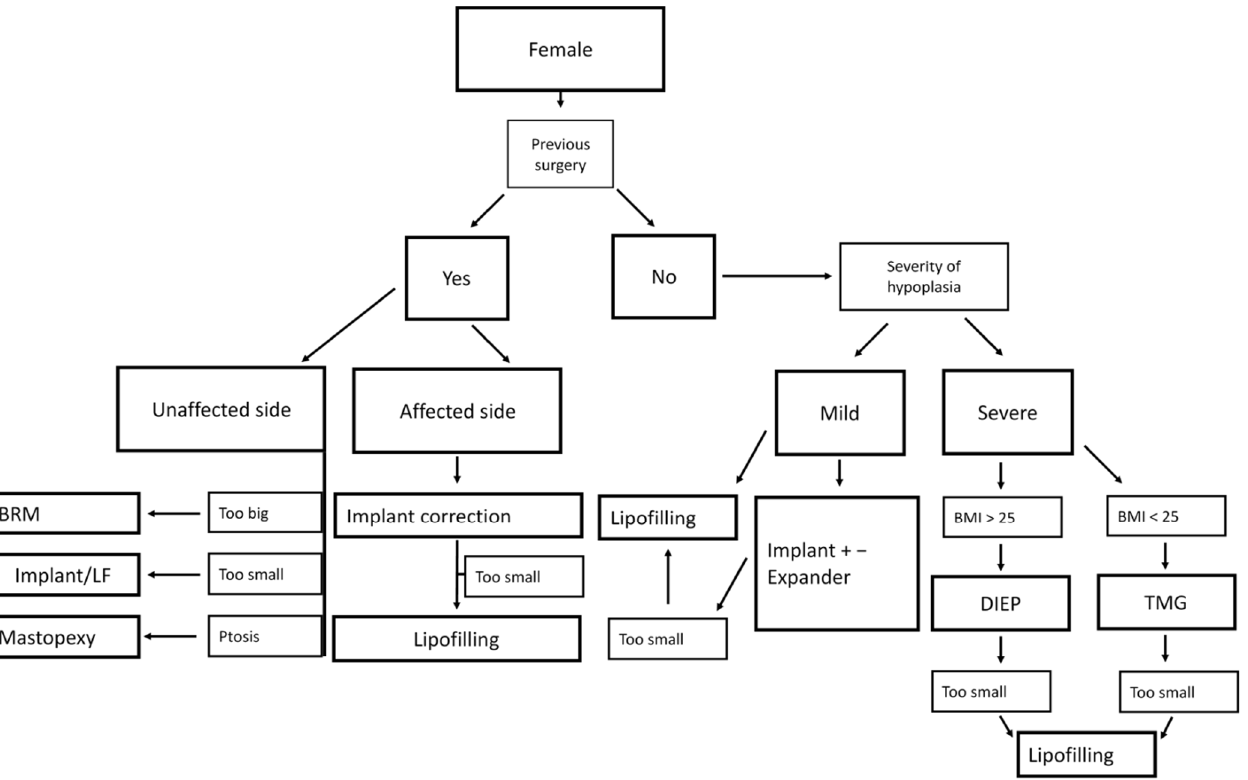
Figure 8. Algorithm for treatment of female patients.